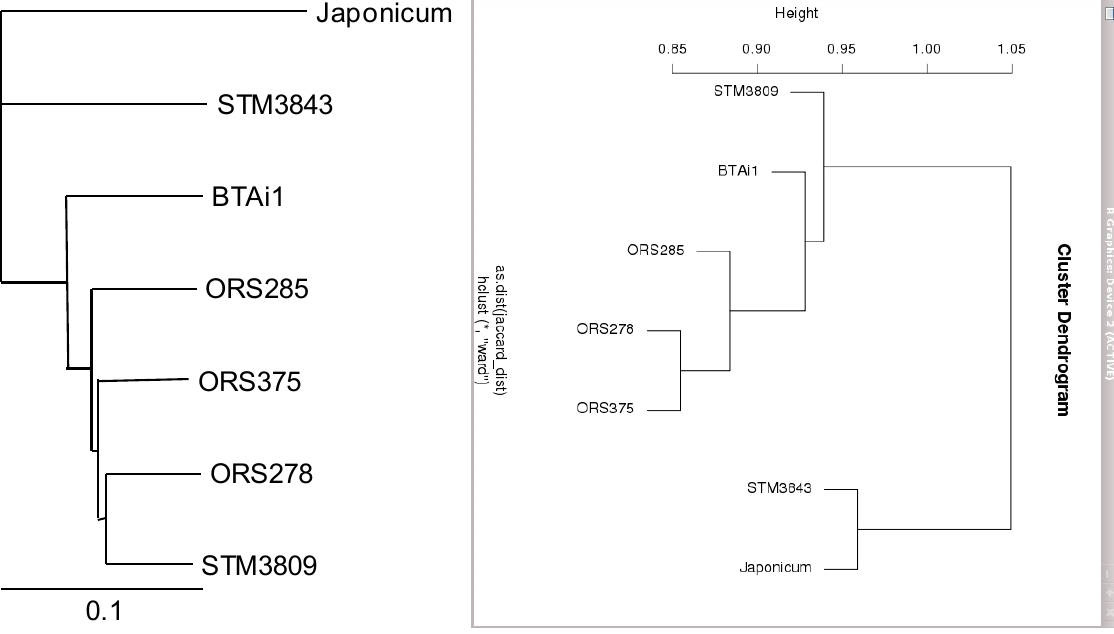
Figure 4. Comparison of core-genome based phylogeny and a dendrogram based on GI distribution across bradyrhizobial